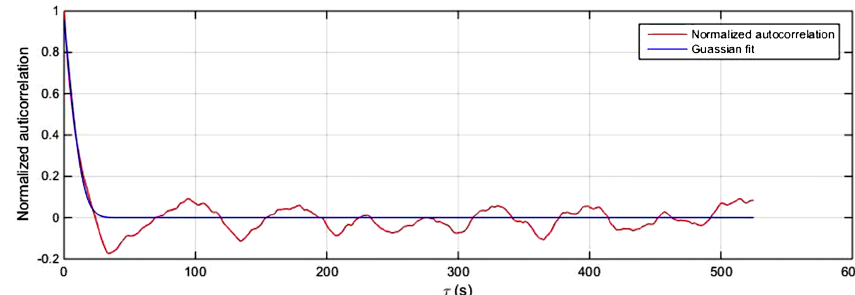
Figure 2. Gaussian fit for a data series of wind velocities u (cid:48) component that allows us to calculate the integral scale.